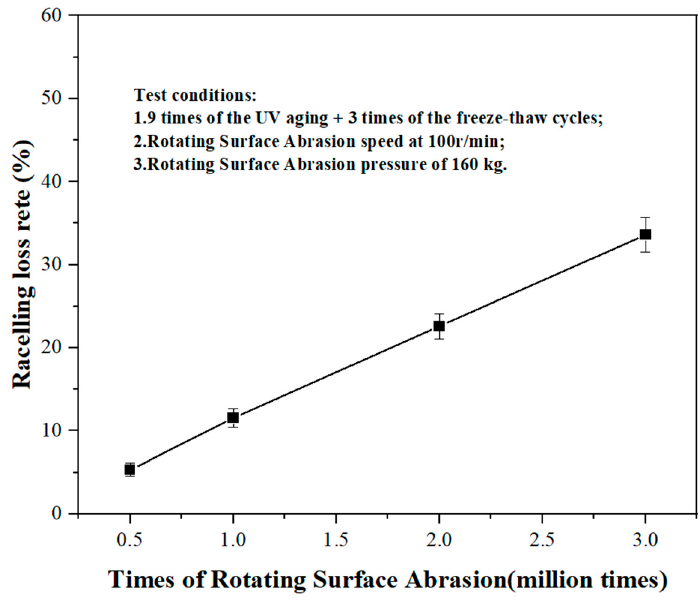
Figure 10. Test results of simulated traffic volume.